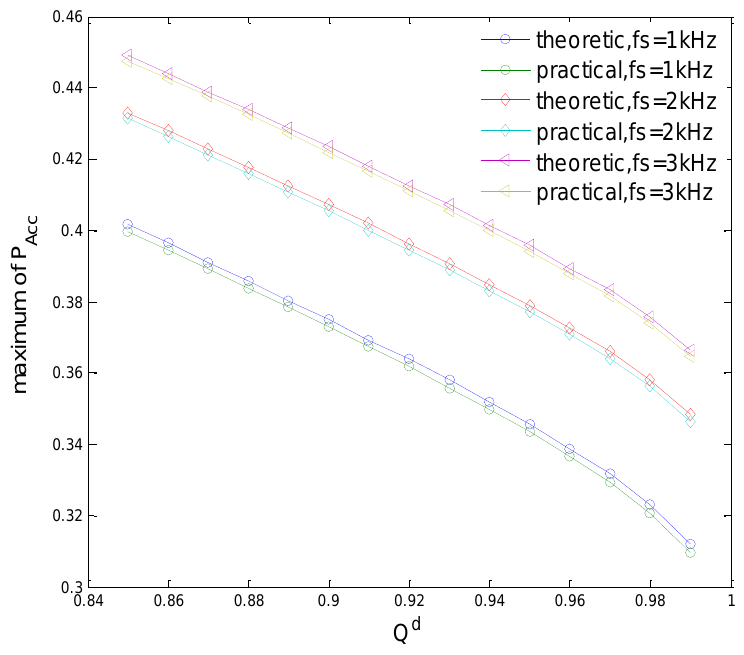
Figure 15. Theoretical and practical maximum spectrum access probabilities.